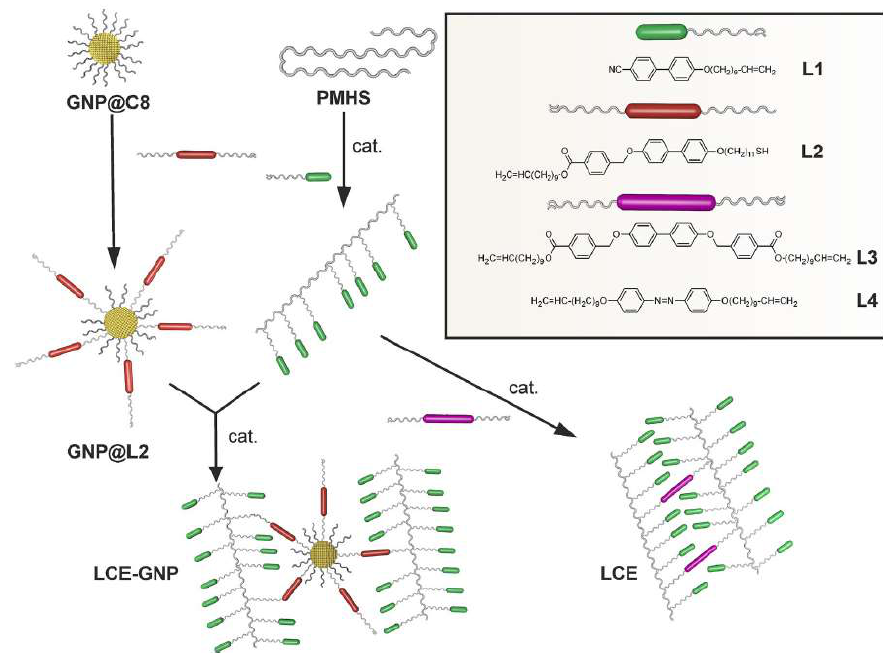
Figure 8. Scheme of the preparation of the LCE-based composites (label LCE-GNP) made of functionalized gold nanoparticles (label GNP@L2) and side-chain LCEs based on polysiloxane chains (PMHS). Mesogenic monomers (label L1) are used as pendant units. Standard LCEs were also prepared with cross-linkers L3 or L4. Reproduced with permission from the authors of [68]. Copyright © 2018 Wiley Online Library.